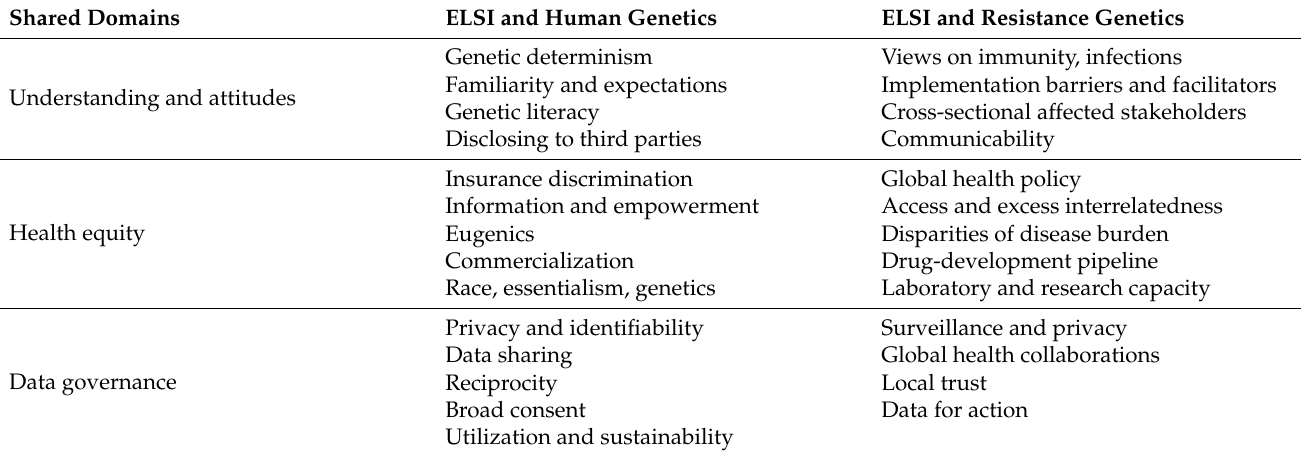
Table 2. Shared Domains for ELSI of Human and Resistance Genetics. Shared